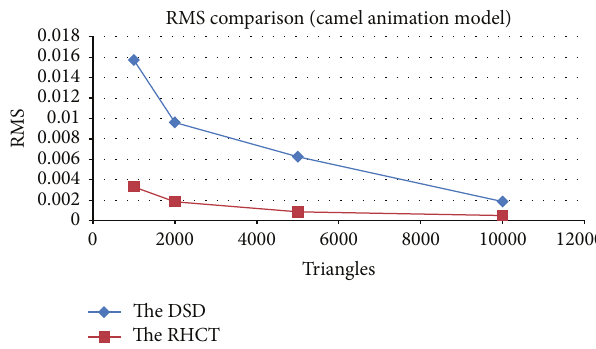
Figure 10: RMS error comparison for simplifying camel animation model.